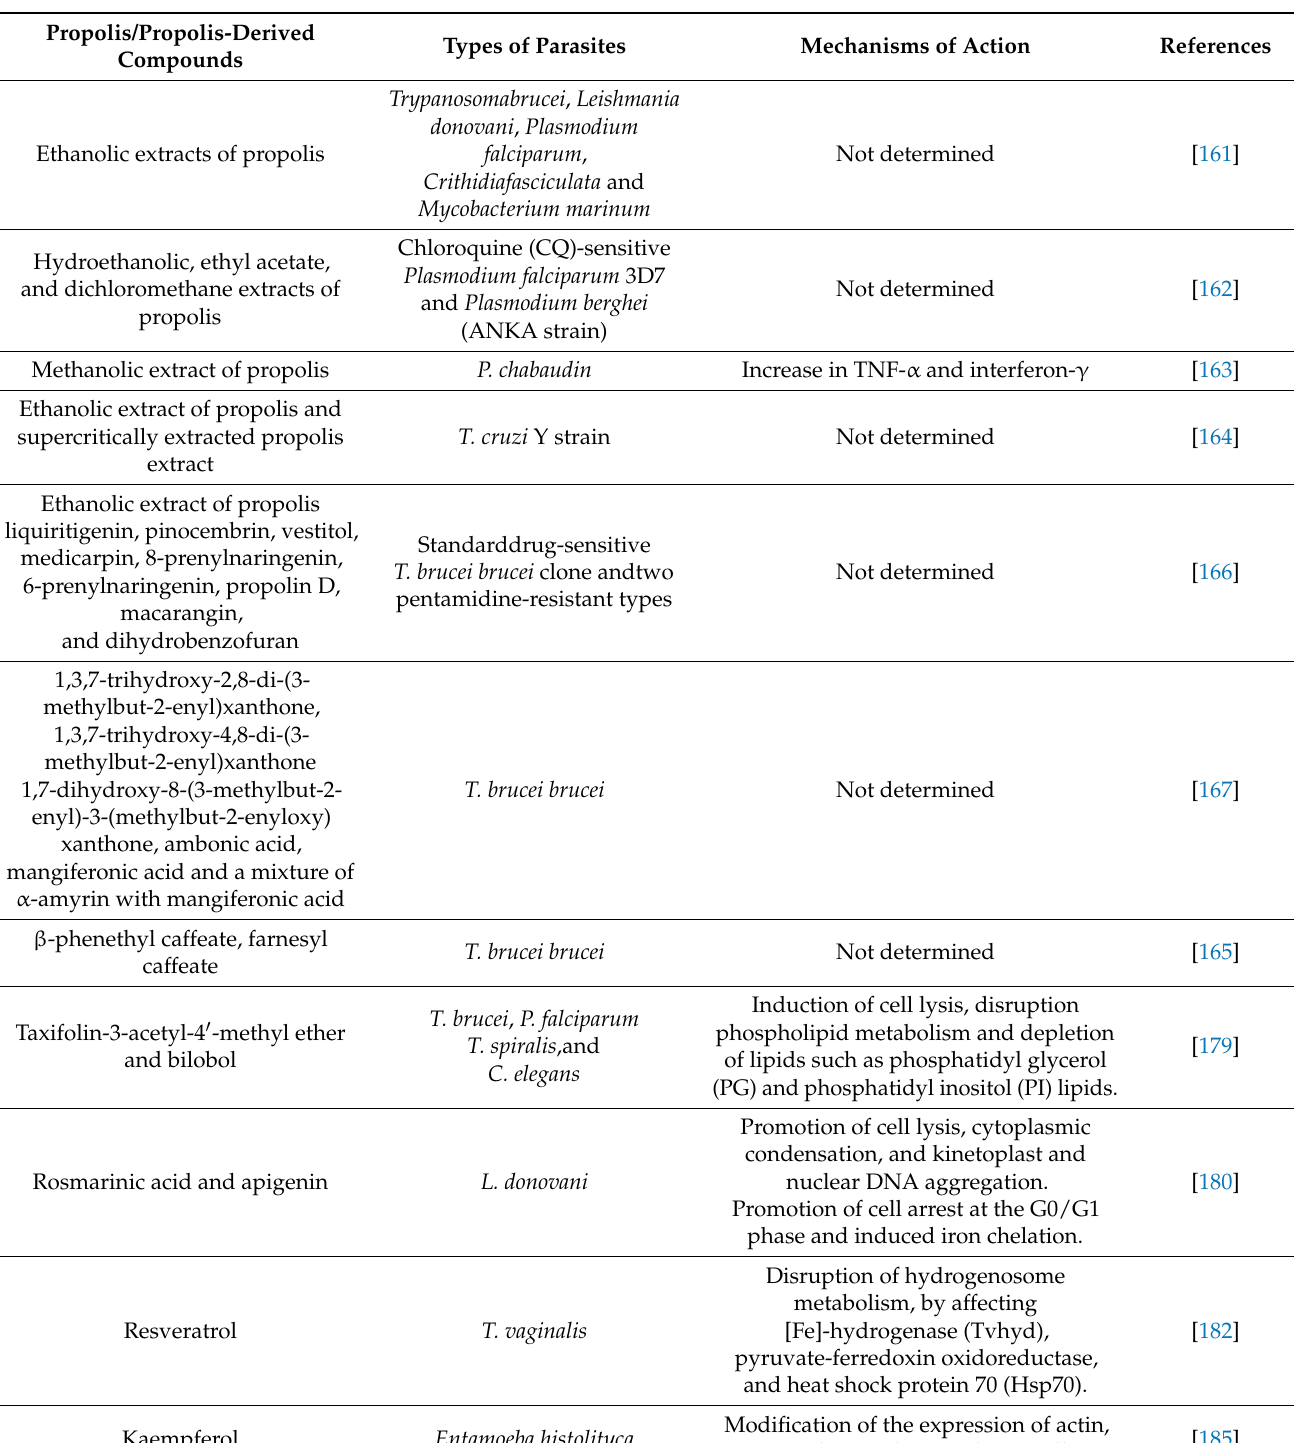
Table 5. Antiparasitic properties of